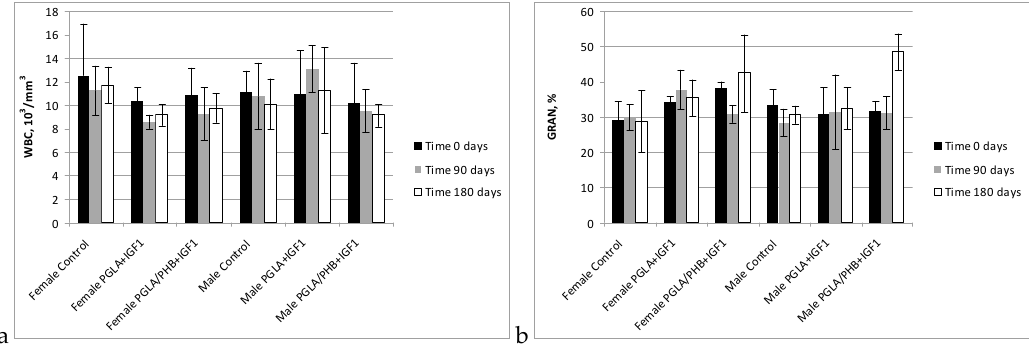
Figure 7. White cell count (WBC) ( a ) and percentage value of granulocytes (GRA) ( b ) in blood of rabbits.